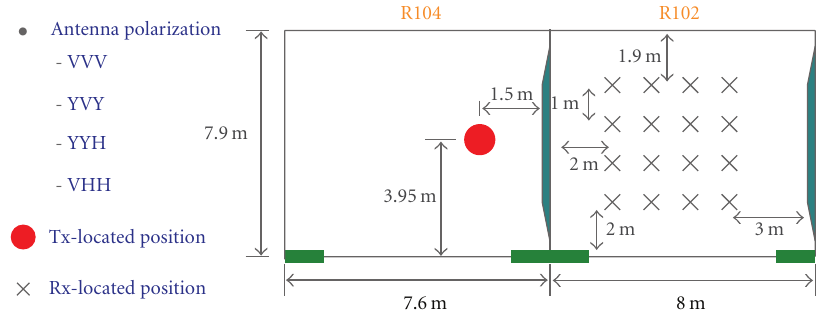
Figure 3: The experimental layout for indoor NLOS environment.